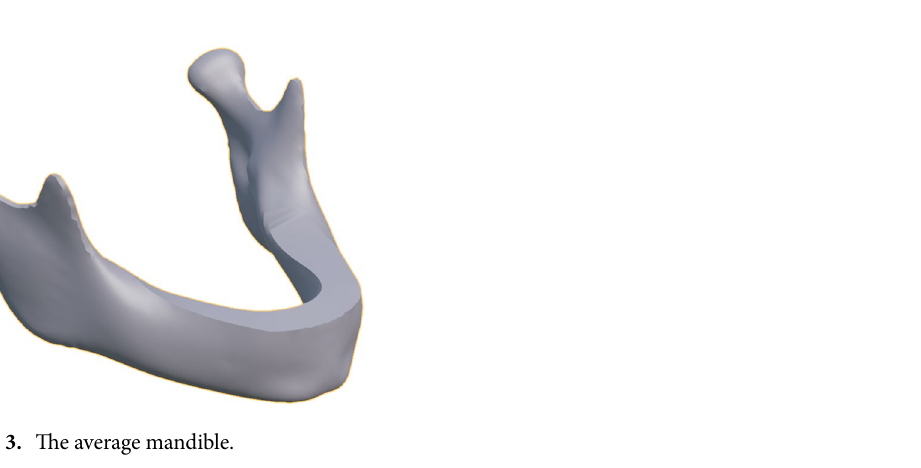
Table 2. Intra-class correlation coefficient (ICC) with 95% confidence interval (CI) for the first ten principal components.